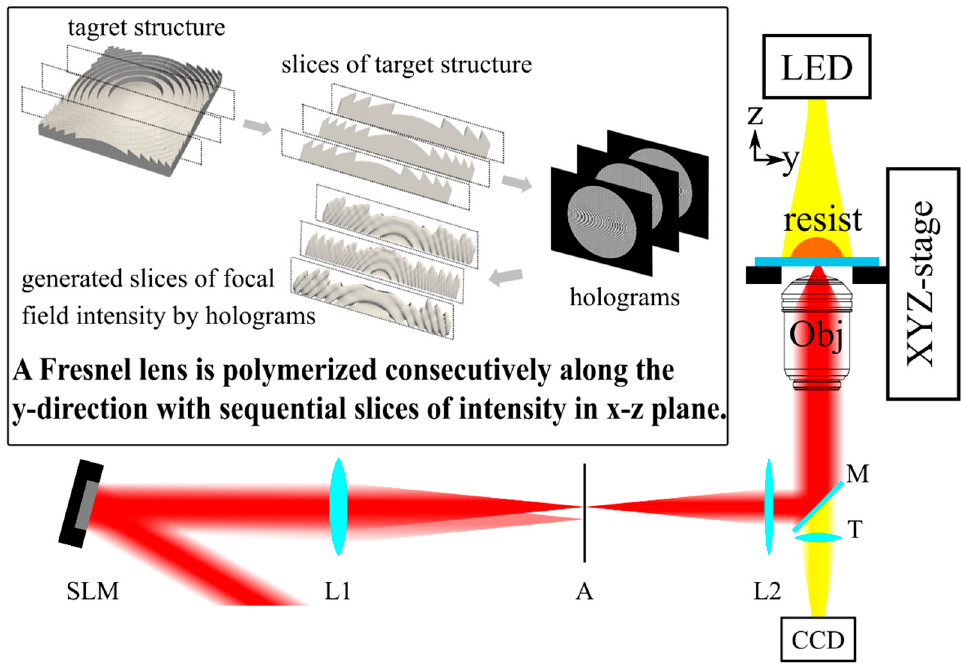
Figure 2. Schematic of the experimental setup for 1D scan two-photon polymerization (TPP) of a Fresnel lens with 3D focal field engineering. SLM: Spatial light modulator; L1 (1000 mm), L2 (400 mm), two lenses of 4f system; A: Aperture; M: Mirrors; LED: Light-emitting diode for illumination; T: Tube lens; Obj: Objective lens; CCD: Charge coupled device. The inset is the flow chart of 2D sliced focal field intensity profiles generated by holograms calculated by the slices of the target structure.